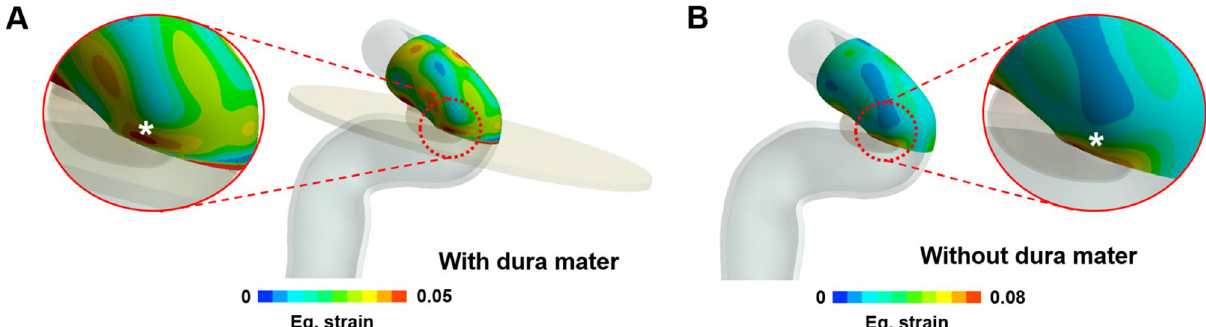
Figure 6. Example of strain distribution change depending on the presence of the dura mater. The strain distribution when the dura mater was considered ( A ). The strain distribution when the dura mater was not employed in FSI analysis ( B ). A white star (*) indicates the location of aneurysm formation site. The strain was extracted at the systolic time.